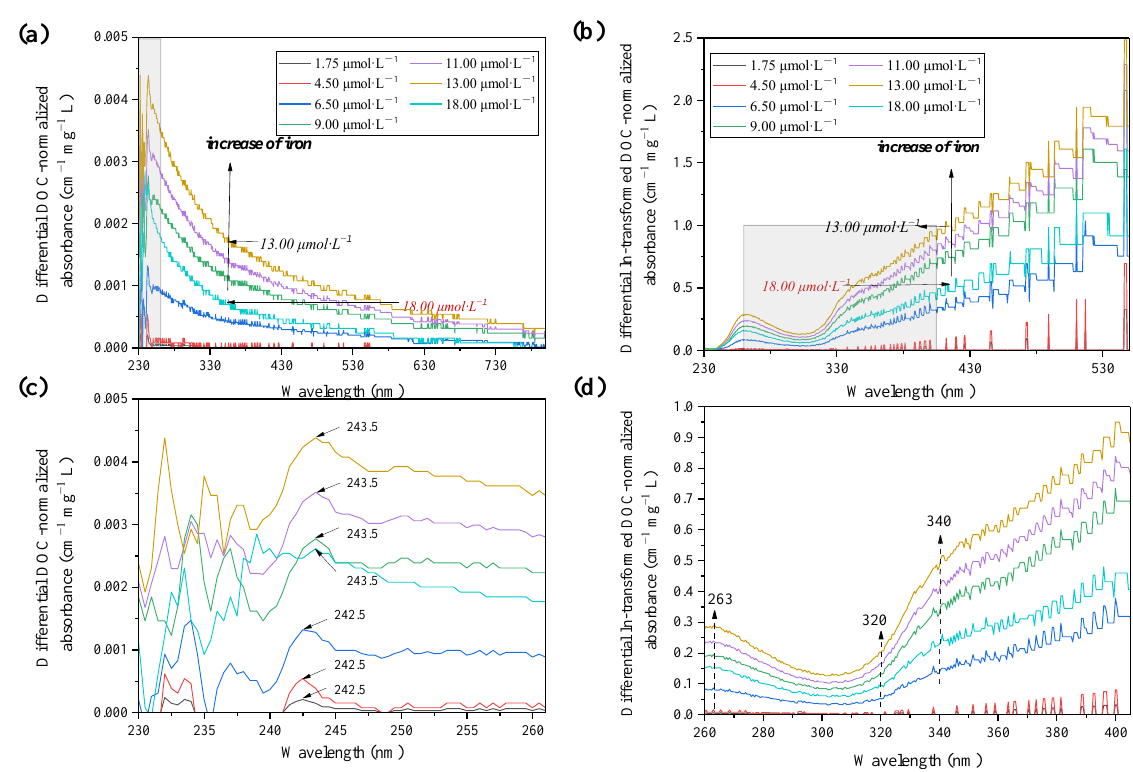
Figure 1. DOC-normalized differential and ln-transformed spectra of the PPFA induced by Fe(III) at varying concentrations. ( b , d ) are enlarged details of ( a , c ), respectively. The concentration of PPFA is 47.7 mg·L −1 and the Fe(III) concentrations range from 1.75 to 18.00 μmol·L −1 .